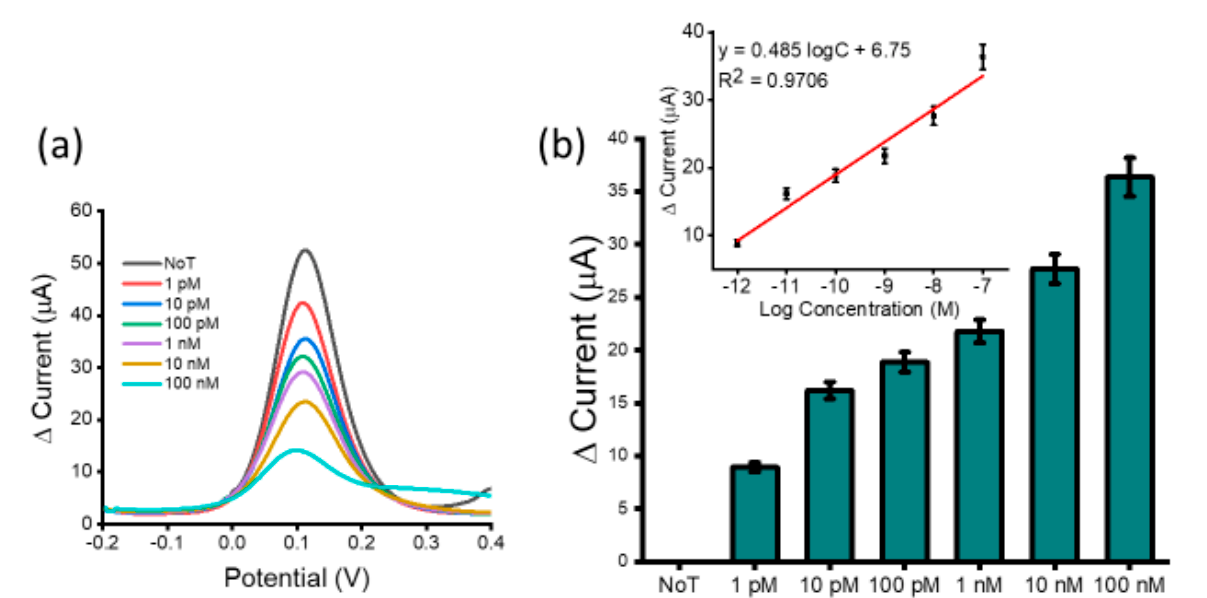
Figure 3. Assay sensitivity: differential pulse voltammetry (DPV) readout depicting current responses for varying concentrations of synthetic HOTAIR lncRNA ( a ) and relative DPV signal change for various synthetic HOTAIR lncRNA concentrations with respect to the NoT ( b ). Error bars represent the standard deviation across three separate experiments. Inset shows the analogous linear calibration plot for current change in reference to the log concentration.